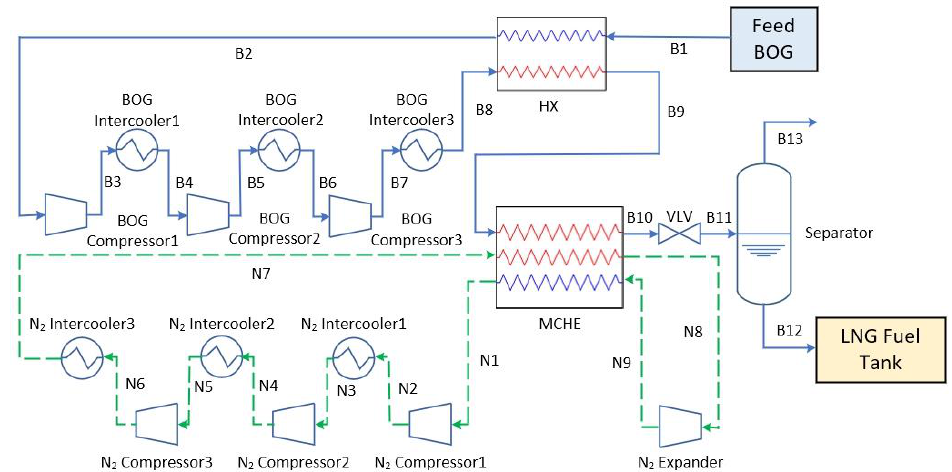
Figure 5. Schematic of the BOG re-liquefaction system for a base case.